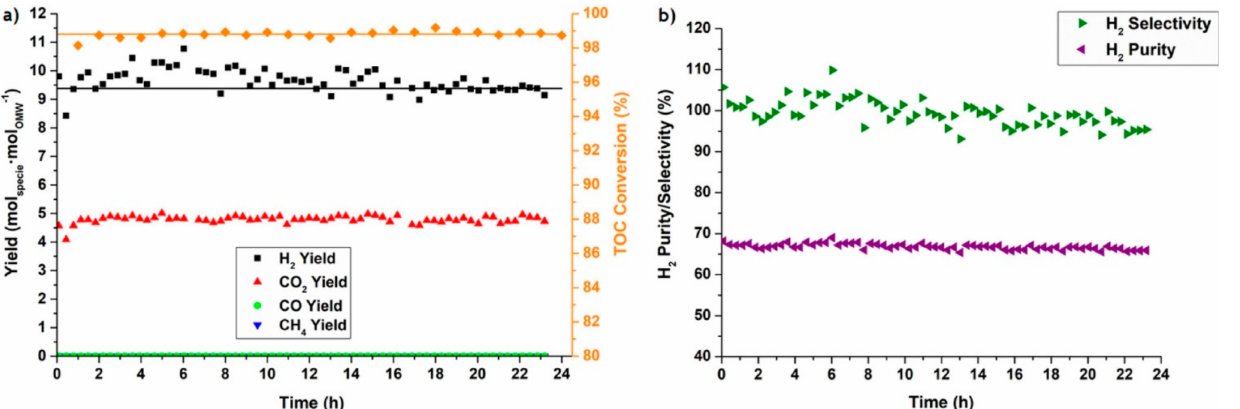
Figure 9. ( a ) Gaseous species yield and TOC conversion during a stability test using a Rh-based catalyst. ( b ) H 2 purity and H 2 selectivity obtained using a Rh catalyst. For interpretation of the references to color in this figure legend, the reader is referred to the Web version of this article. Reprinted with permission from Ref. [85]. Copyright 2021